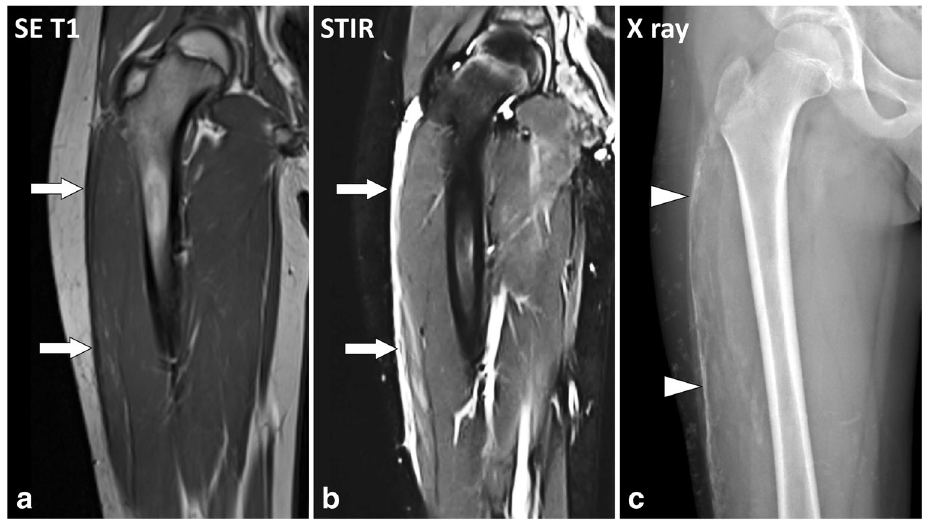
Fig. 12 Coronal ( a ) SE T1- weighted and ( b ) STIR images and ( c ) plain X-ray of the right thigh of a 9-year-old boy with dermatomyositis. MRI shows thickening and fluid signal inten- sity of the deep peripheral fascia of the lateral part of the thigh (ar- rows). Plain X-ray demonstrates diffuse calcifications of the deep peripheral fascia (arrowheads), which are not visible at MRI